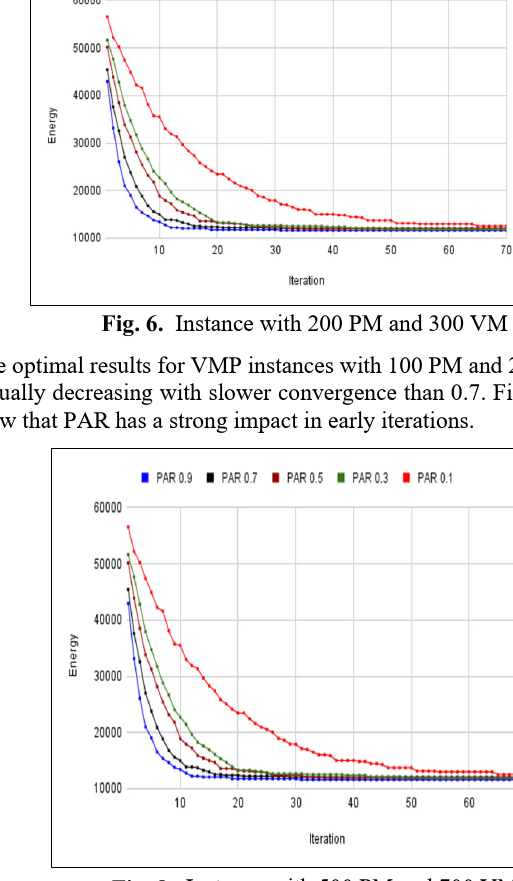
Fig. 7. Instance with 300 PM and 450 VM Fig. 8. Instance with 500 PM and 700